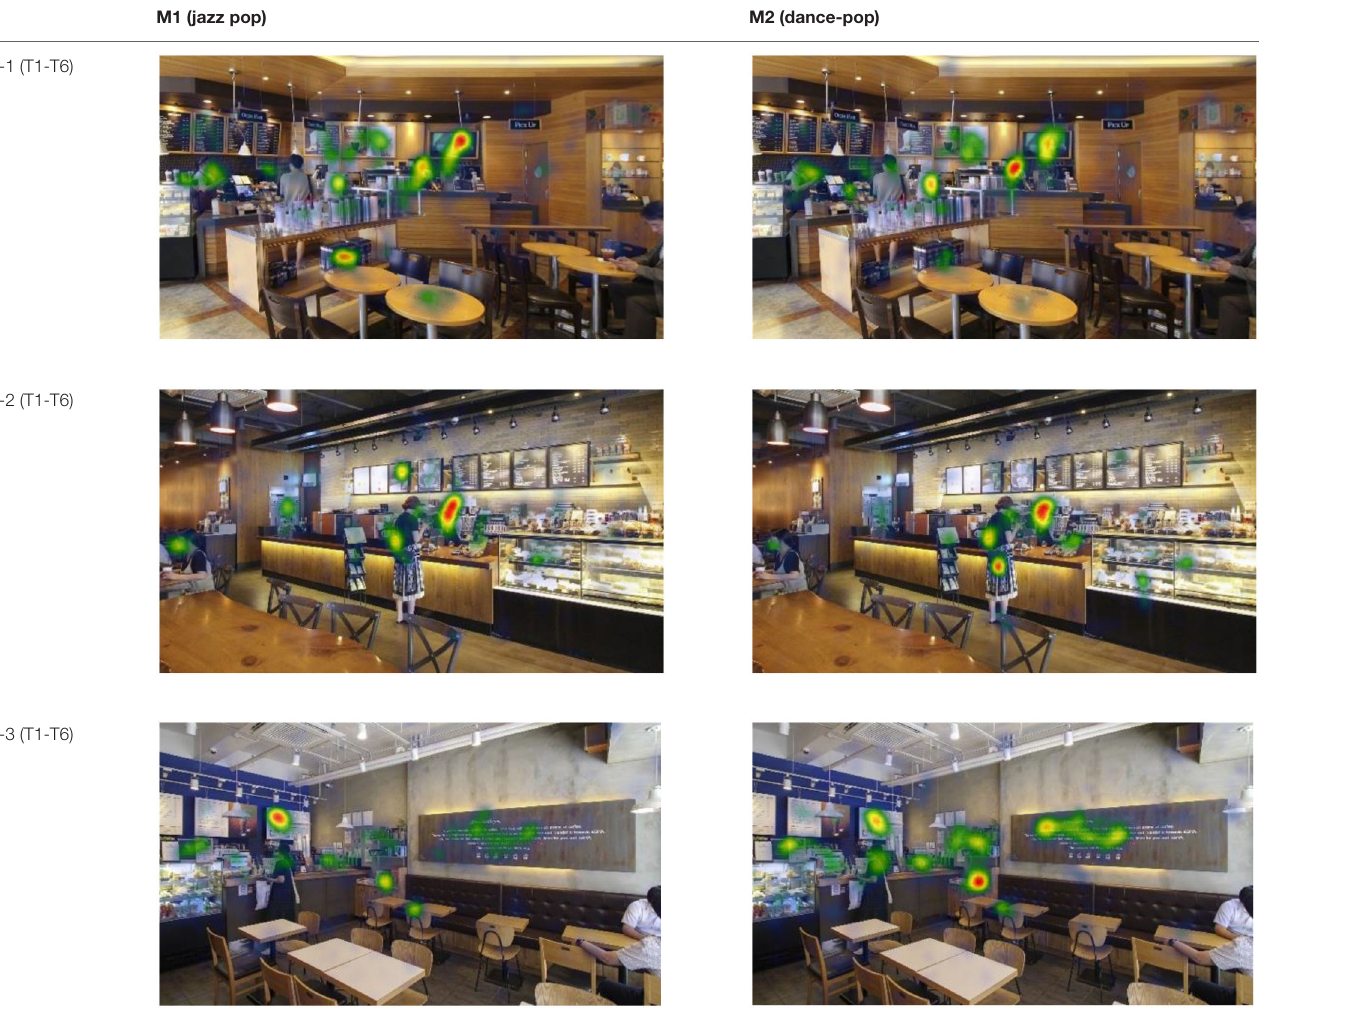
TABLE 6 | Heatmaps: red areas indicate higher fixation counts and yellow and green areas show lower fixation